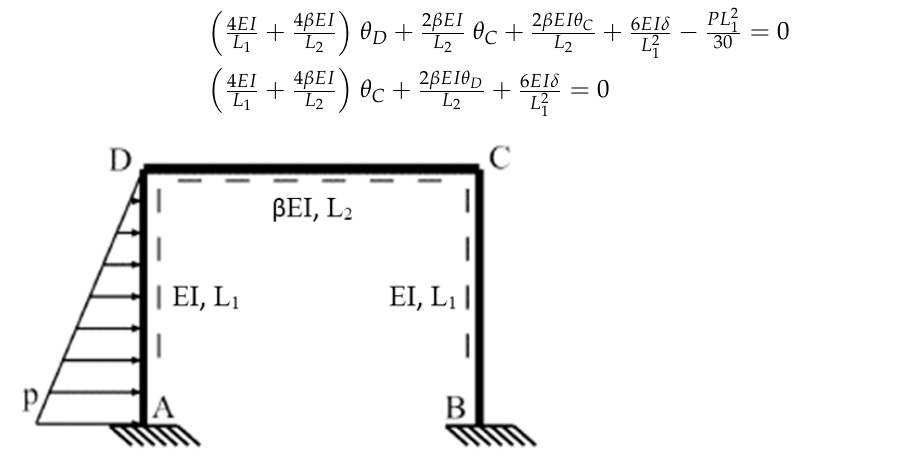
Figure 14. Frame subjected to non-symmetrical loading ( p ) .